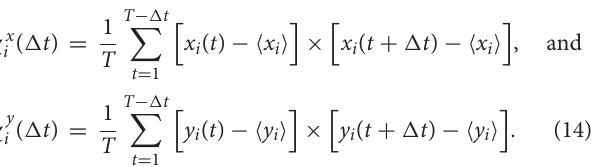
rattler motion out from the overall collective behavior, leaving a set of N N r eigenmodes and eigenvalues for downstream −